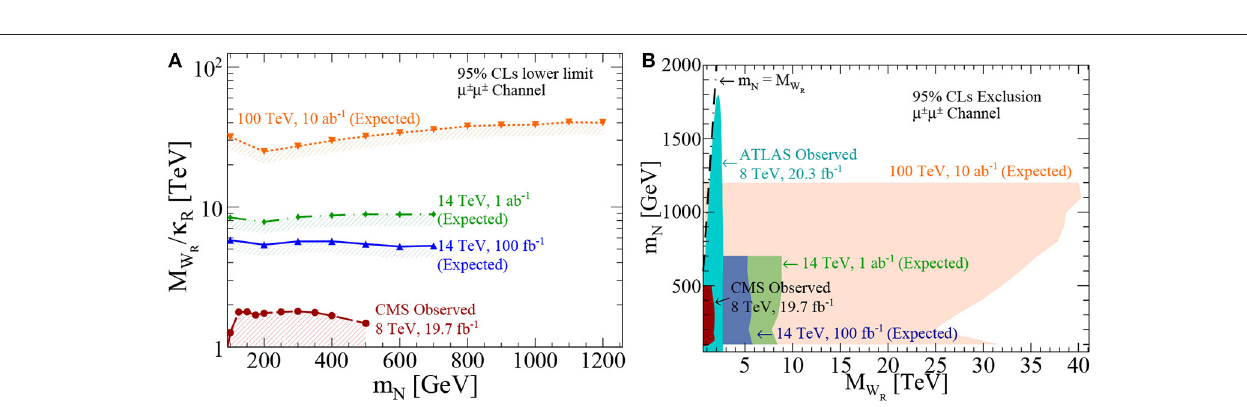
g R / g L , the observed 8 TeV LHC 95% CLs lower limit on ( M W FIGURE 21 | (A) As a function of M N and for right-left coupling ratio κ R = TeV sensitivity with L 100 fb − 1 (solid-triangle) and 1 ab − 1 (dash-dot-diamond), and expected 100 TeV VLHC sensitivity with 10 ab − 1 (dot-star). (B) Observed and = expected 95% CL s sensitivities to the ( M W , M N ) parameter space for various collider configurations via direct and indirect searches in the µ ± µ ± final state R